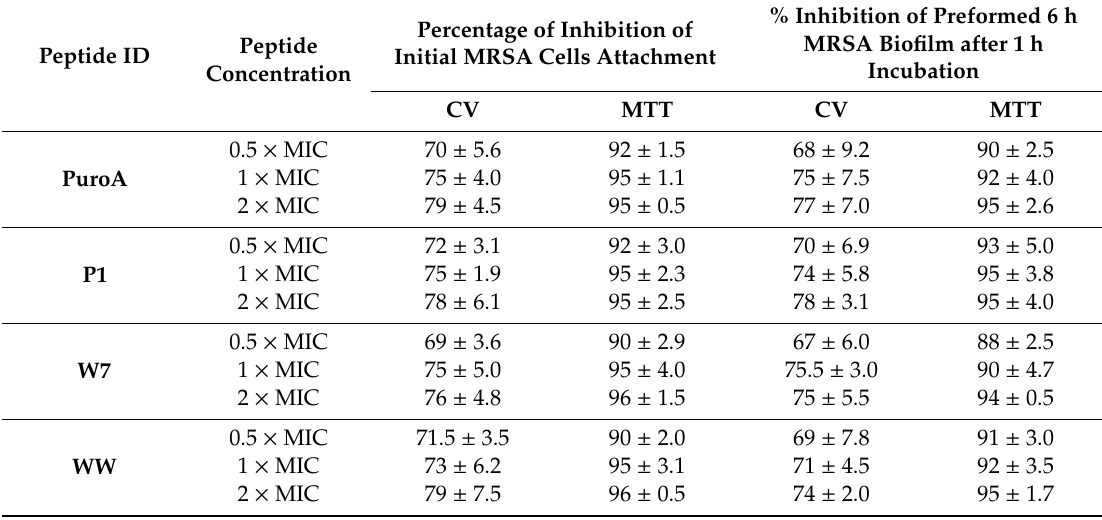
Table 4. E ff ects of peptides on initial cell attachment and preformed biofilms of MRSA M173525.